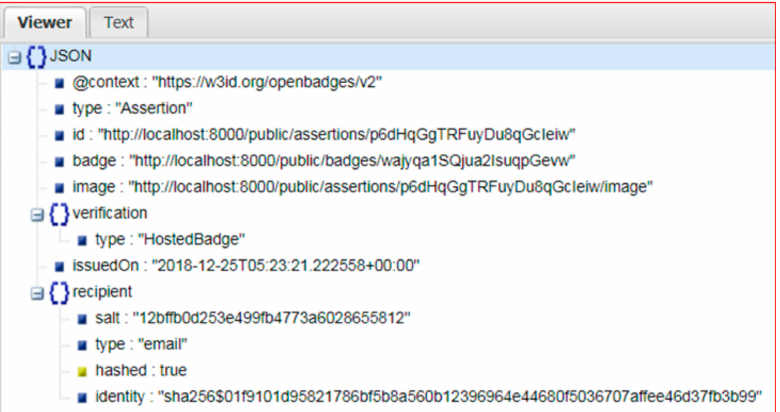
Figure 6. Digital badge assertion